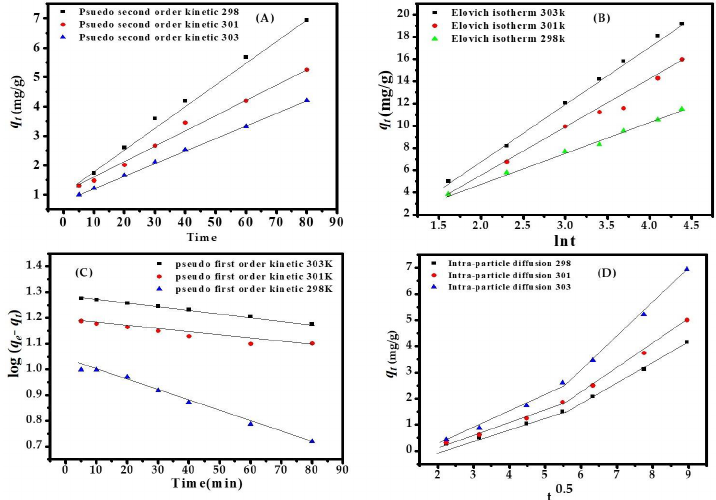
Figure 5. ( A ) Pseudo second order kinetic model ( B ) Elovich kinetic model ( C ) kinetic first order ( D ) Intrapartcle diffusion kinetic model for adsorption of MB dye at various temp